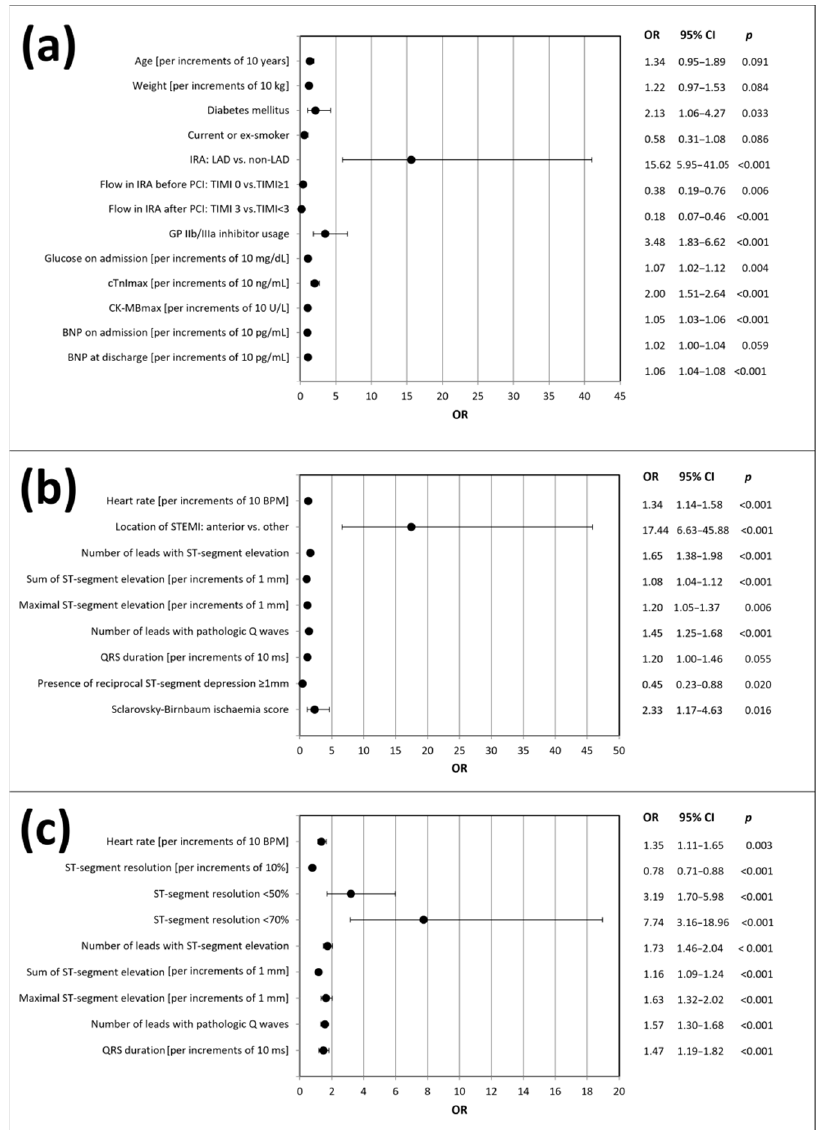
Figure 2. Predictors of LVSD occurrence after 6 months of follow-up according to the univariate logistic regression analysis: ( a ) demographic, clinical, angiographic and biochemical variables; ( b ) baseline electrocardiographic variables; ( c ) post-PCI electrocardiographic variables. BNP, B-type natriuretic peptide; CK-MBmax, maximal activity of isoenzyme MB of creatinine kinase; cTnImax, maximal concentration of troponin I; CI, confidence interval; IRA, infarct-related artery; LAD, left anterior descending artery; LVSD, left ventricular systolic dysfunction; ms, milliseconds; OR, odds ratio; PCI, percutaneous coronary intervention; STEMI, ST-segment elevation myocardial infarction; TIMI, thrombolysis in myocardial infarction score.